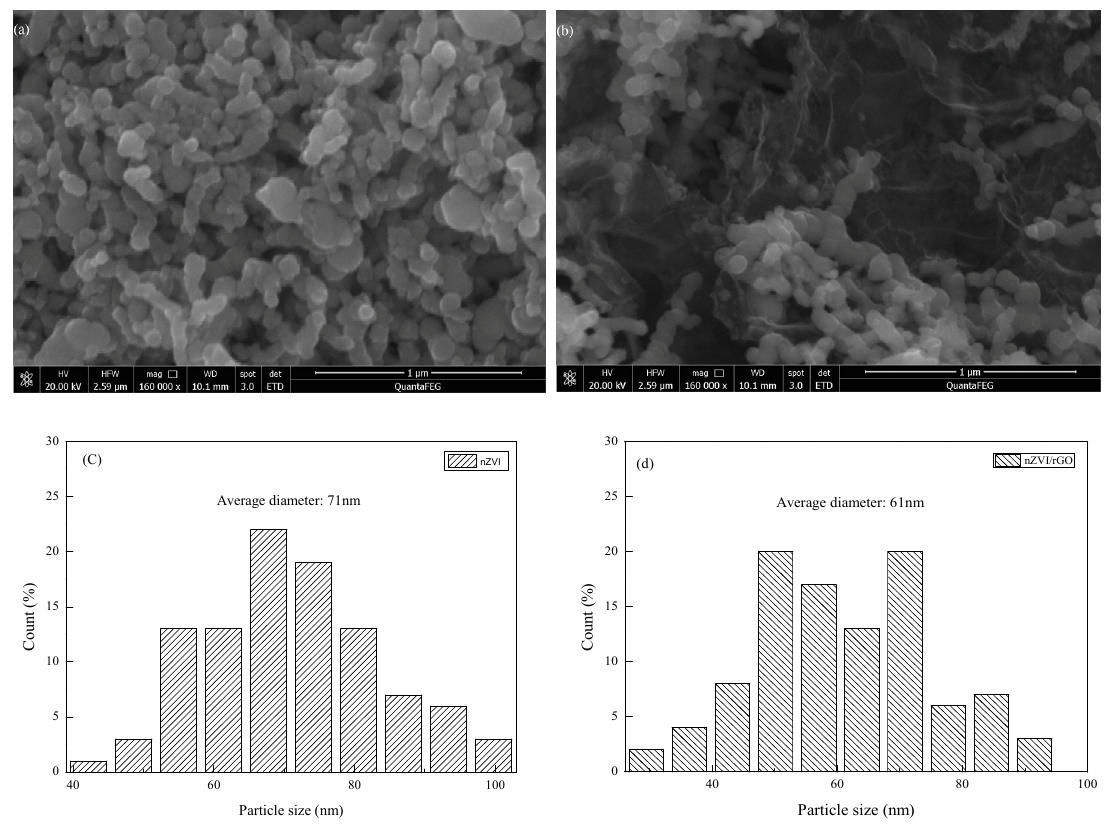
Figure 4. Scanning electron microscopy (SEM) images of nanoscale zero-valent iron (nZVI) ( a ) and nZVI/ graphene oxide (rGO) ( b ); Size distributions calculated from the SEM images for nZVI ( c ) and nZVI/rGO ( d ).